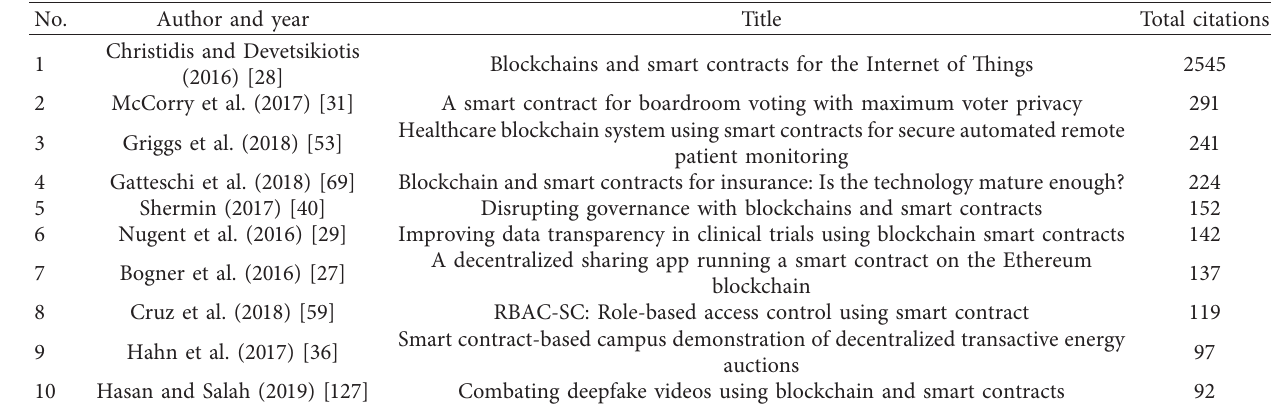
Table 4: The top 10 cited